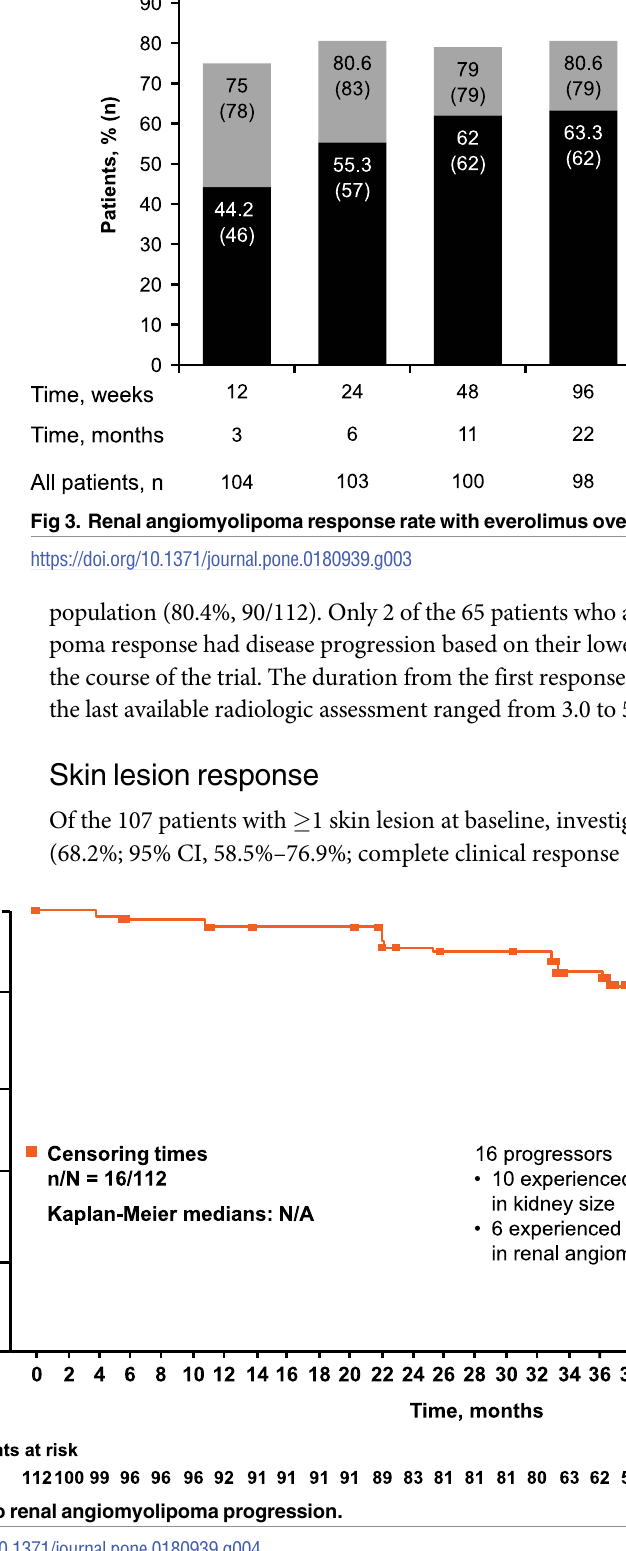
Fig 4. Time to renal angiomyolipoma